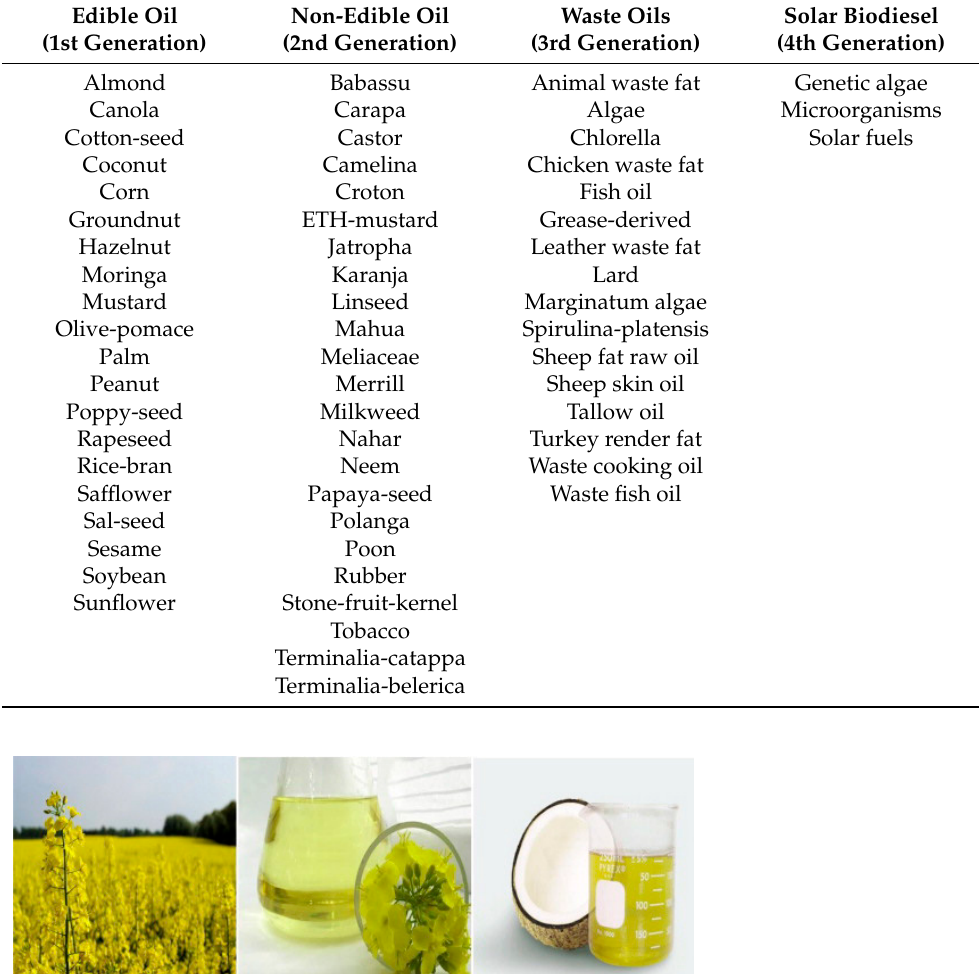
Table 3. Feedstocks for different generation of biodiesel production [89,116,117].